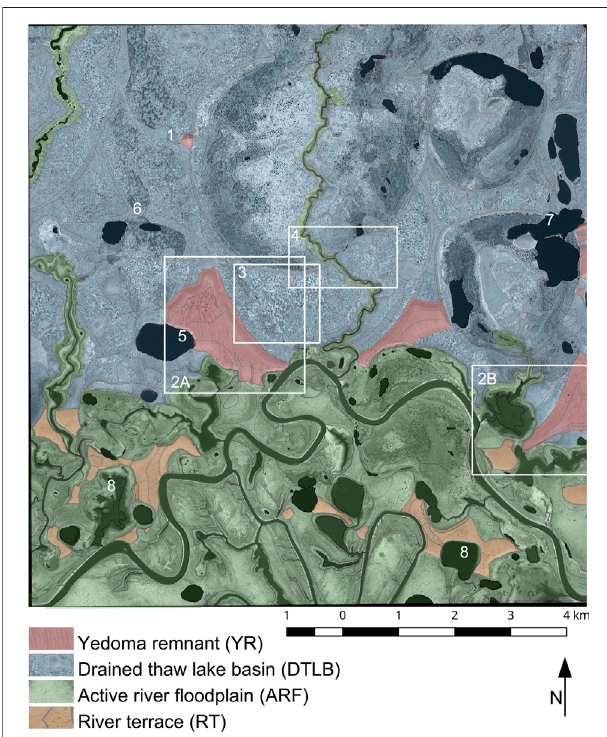
FIGURE 4 | Main landform classes in the study area. Backdrop: 2019 Worldview panchromatic image. Numbers referto locations discussed in text, rectangles to locations of other fi gures. WorldView © 2019